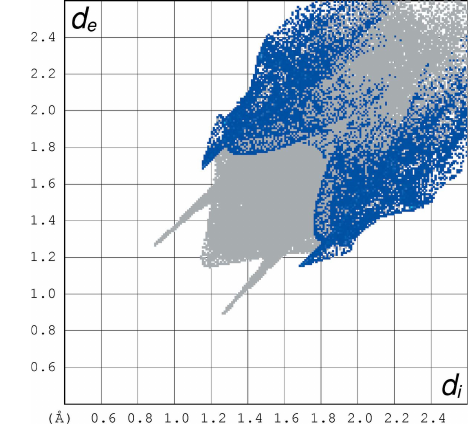
Figure 5 The two-dimensional fingerprint plot for the title compound depicting the contribution of the C (cid:3)(cid:3)(cid:3) H contacts.